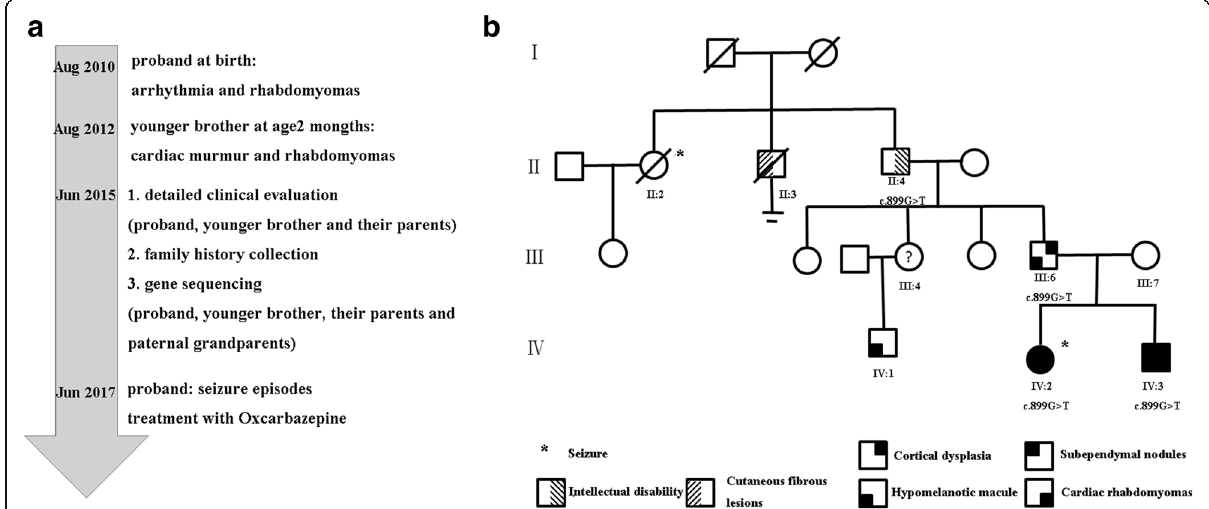
Fig. 2 Pictures of timeline and pedigree. The timeline picture of clinical management for the affected siblings is listed ( a ), and the pedigree of the family indicates individual phenotype ( b )